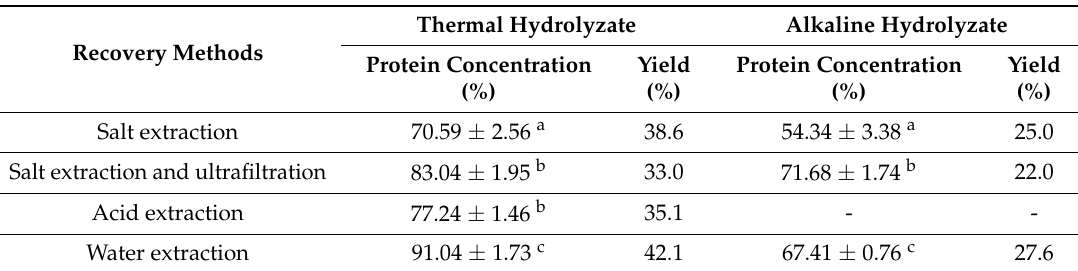
Table 1. Protein concentration and yield of proteinaceous products recovered from hydrolyzate by different methods. Table adopted with copyright permission from Elsevier (for Mekonnen et al.,